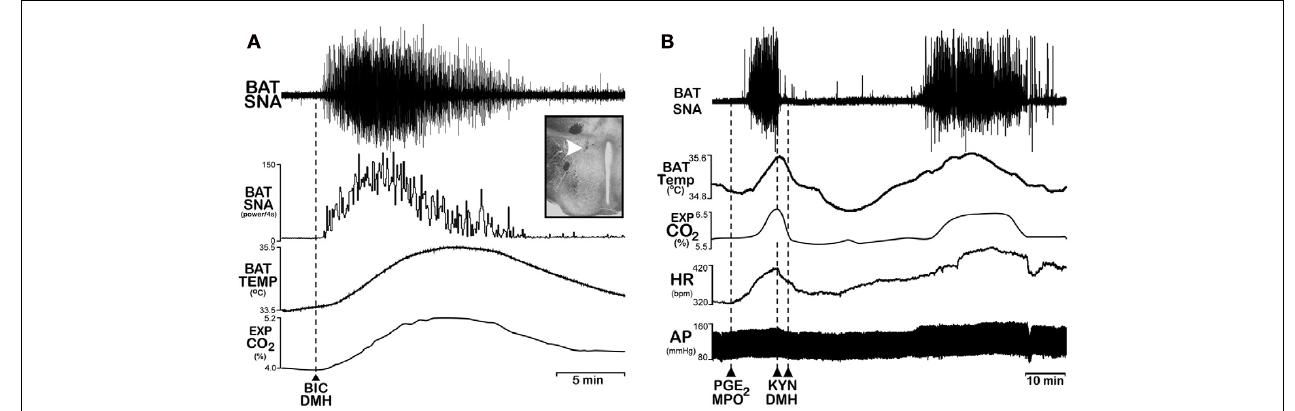
Temp), and expired CO 2 . Modified with permission from Morrison et al. (2004). (B) Nanoinjection of prostaglandin E 2 (PGE 2 ) into the medial preoptic area (MPO) increased BAT SNA, BATTemp, Exp CO 2 , heart rate (HR), and arterial pressure (AP). Subsequent bilateral nanoinjection of the glutamate receptor antagonist, kynurenate (KYN), into the DMH completely reversed these PGE 2 -evoked responses. Modified with permission from Madden and Morrison